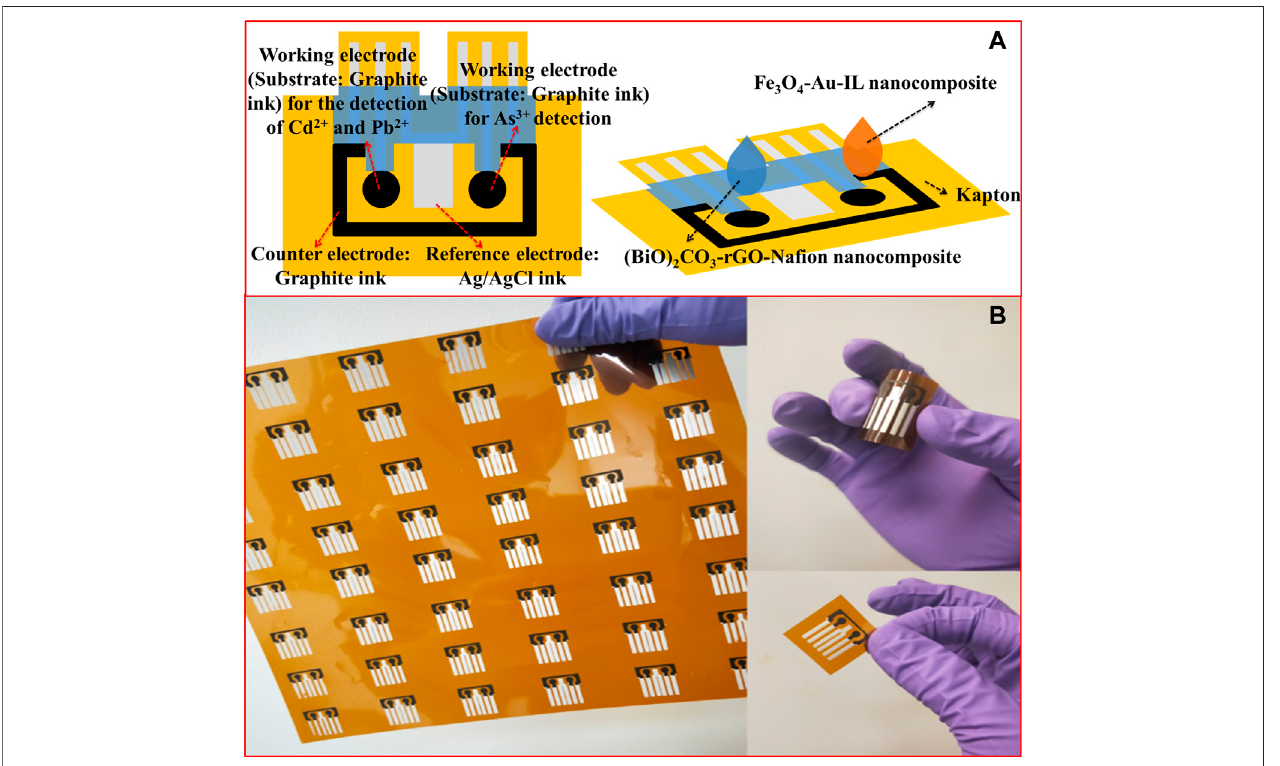
FIGURE 1 | (A) Schematic diagram of the SPE. (B) Optical images of the SPE.